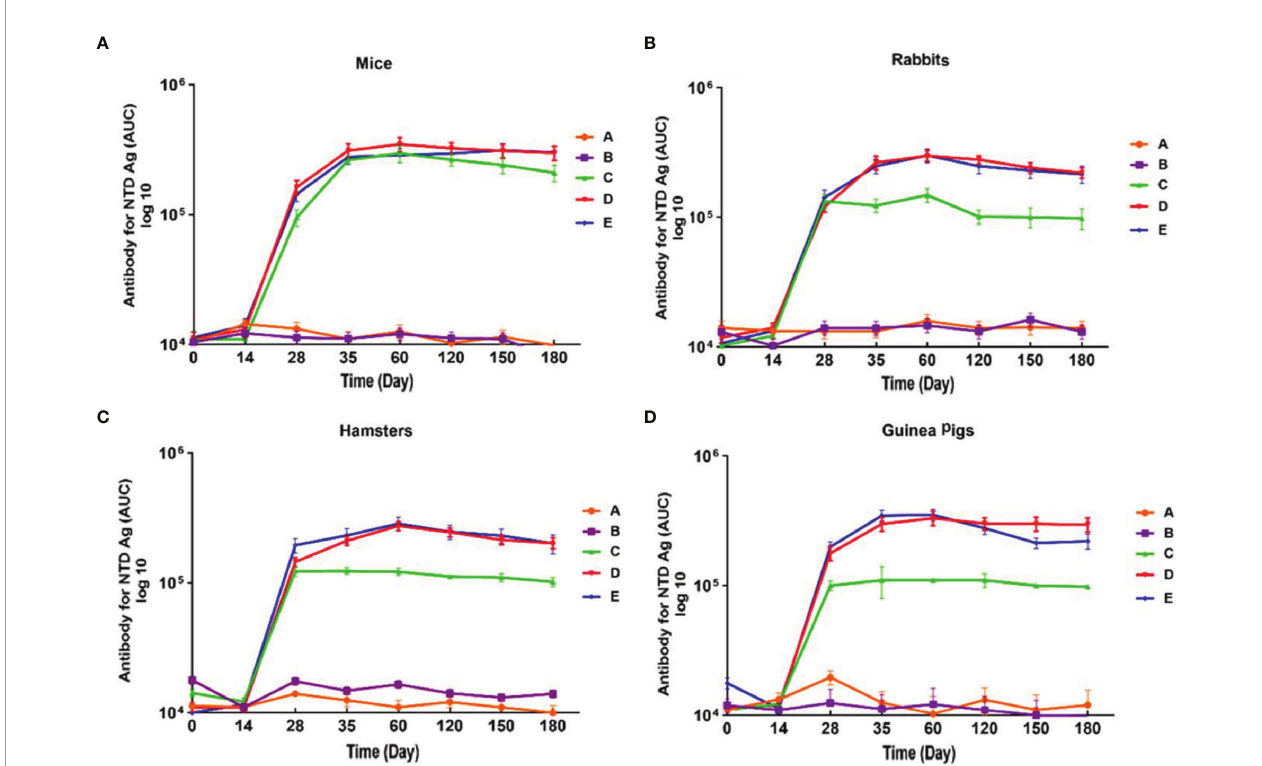
FIGURE 4 | Anti-SARS-CoV-2 immunoglobulin-G (IgG) antibody titers against NTD antigen in different animal models immunized with candidate vaccine. (A) Anti- SARS-CoV-2 immunoglobulin-G (IgG) antibody titers against NTD for 180 days from the day it is received candidate vaccine in mice. (B) Anti-SARS-CoV-2 immunoglobulin-G (IgG) Antibody titers against NTD for 180 days from the day it is received candidate vaccine in rabbit. (C) Anti-SARS-CoV-2 immunoglobulin-G (IgG) antibody titers against NTD for 180 days from the day it is received candidate vaccine in hamster. (D) Anti-SARS-CoV-2 immunoglobulin-G (IgG) antibody titers against NTD in for 180 days from the day it is received candidate vaccine in guinea pig. Data are presented as mean ± SD. The levels of statistical signi fi cance for differences between test groups were determined using one-way ANOVA followed by Tukey ’ s post hoc test. Statistical comparison was done by comparing the vaccinated group with the placebo group as a control. A signi fi cant increase of IgG against the NTD was observed one week after the second dose of the candidate vaccine (day 28) in all animal groups receiving the low, middle, and high doses of candidate vaccine and remained signi fi cantly higher until day 180 in compared with the groups receiving placebo and adjuvant (P<0.001). Placebo (adjutant of RAS-01) (group A), phosphate buffered saline (PBS, group B), low dose candidate vaccine (group C), medium dose candidate vaccine (group D), and high dose candidate vaccine (group